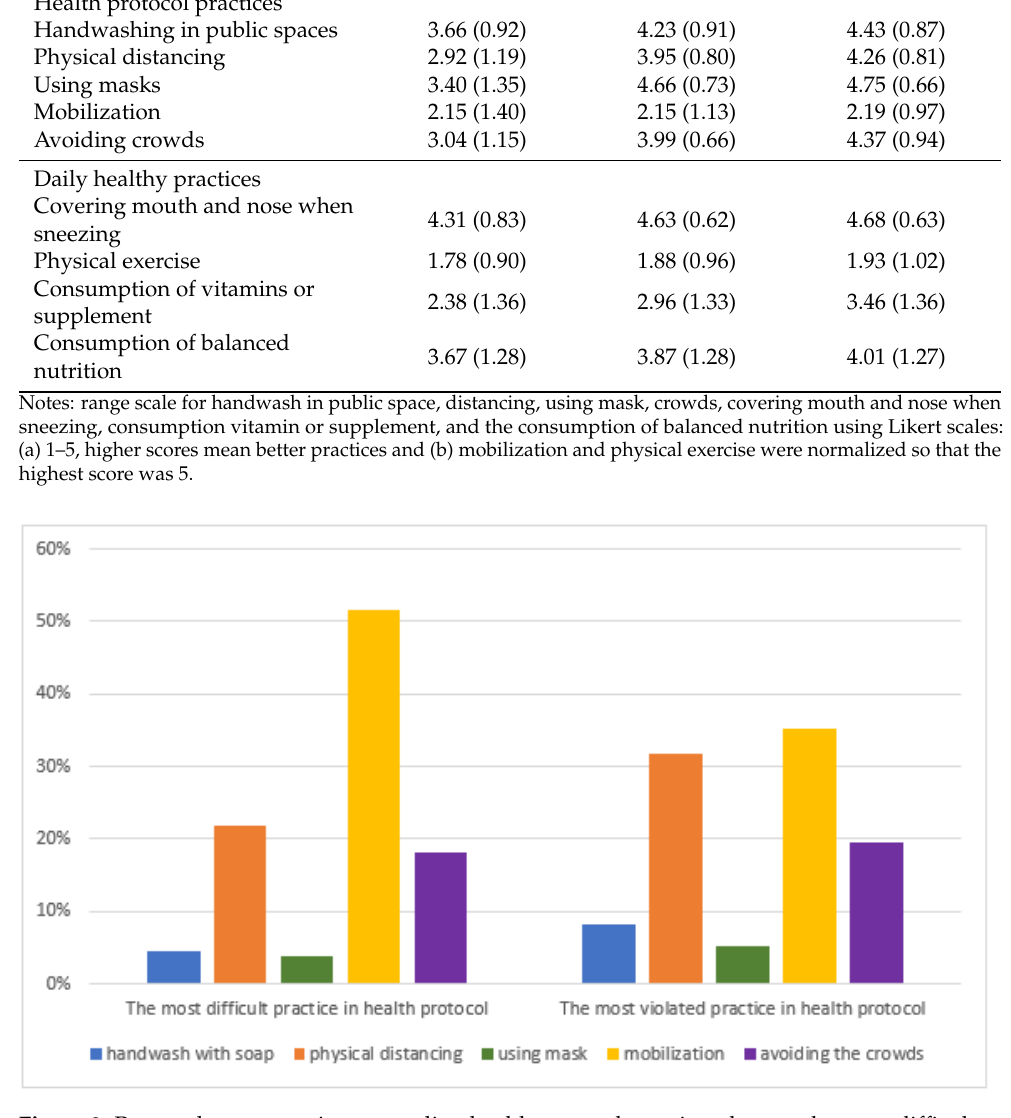
Figure 2. Respondent proportions regarding health protocol practices that are the most difficult to carry out and the most violated in the pandemic.